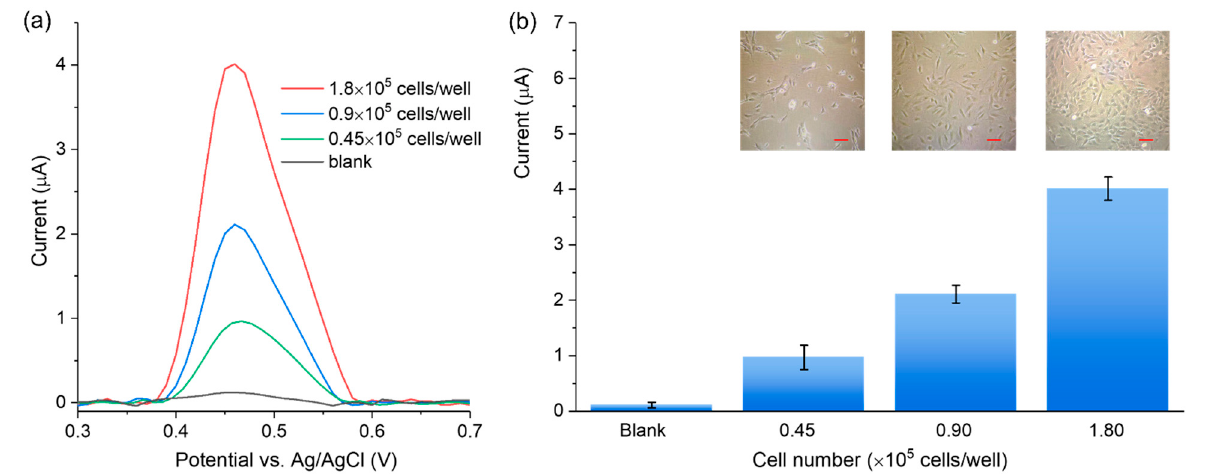
Figure 6. ( a ) DVP curves obtained from the supernatant of a series of IDG-SW3 cell densities; ( b ) the DPV signal increases with the rising cell densities, and the insets show optical images of the IDG-SW3 cells in the differentiation stage with different densities (scale bar = 25 μ m).